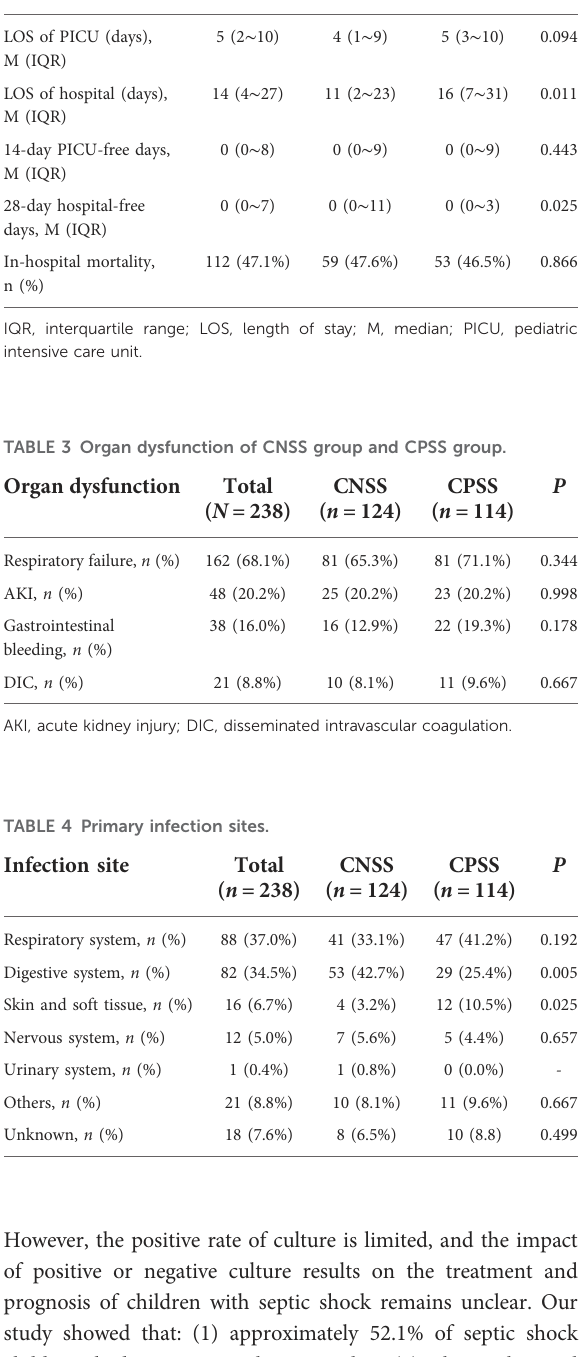
TABLE 2 Clinical outcomes according to the culture results. Characteristics